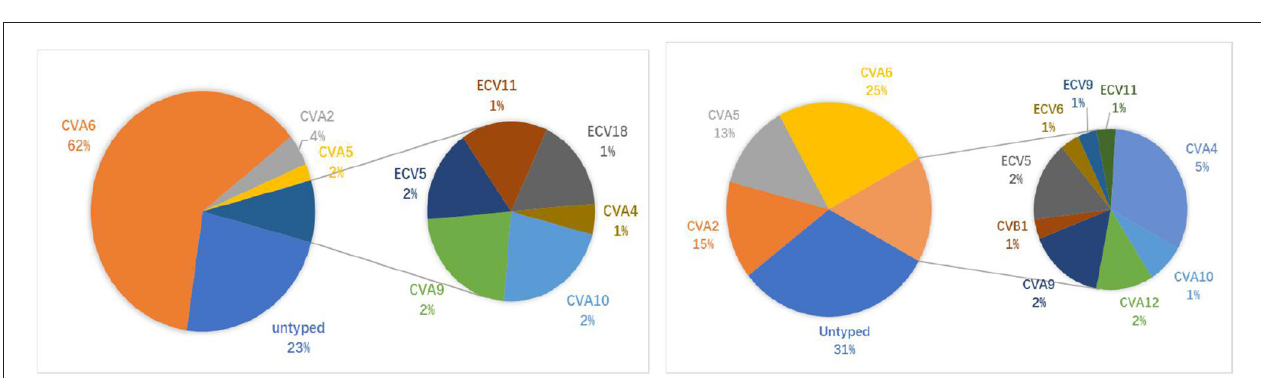
Frontiers in Medicine |